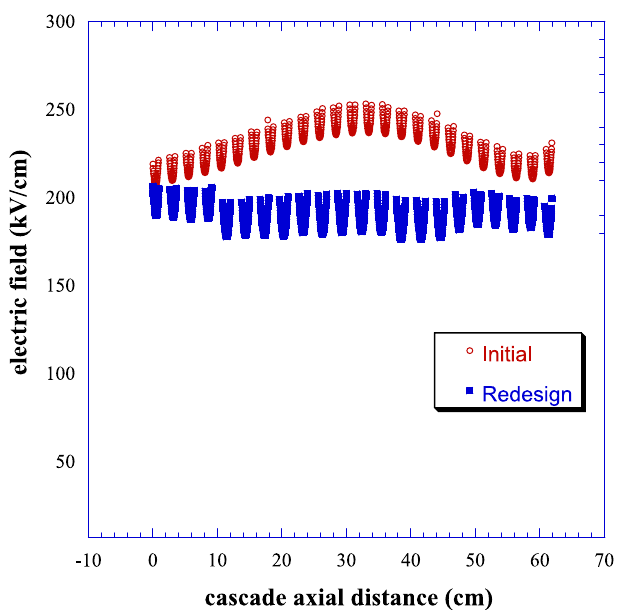
FIG. 20. (Color) Cascade electric field in each gap at 6 MV charge. The trigger gap is at d (cid:2) 0 .